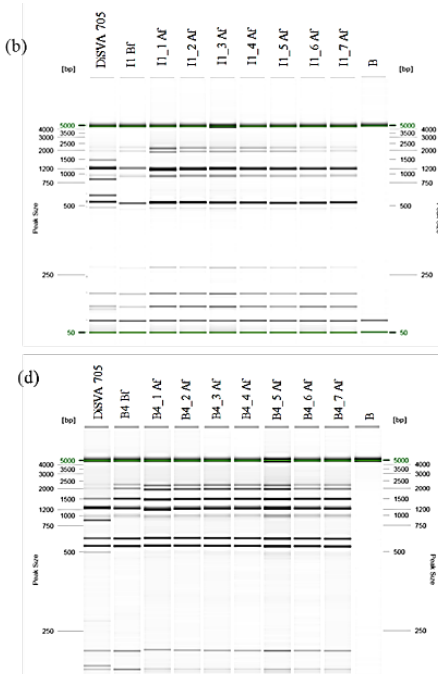
Figure 3. Electrophoretic profiles of interdelta sequences obtained by primer pair δ 12–21. Each stable isolate, belonging to each group, was named from 1 to 7 preceded by strain’s name and compared with the same unstabilized strain. The DiSVA 705 strain was used as control. The acronyms “Bf” and “Af” were used to indicate before and after genome stabilization, respectively. Lane B: indicated as negative control. The QX Size Marker 50 bp/ 5kb (Qiagen) was used for fragment size. ( a – d ) represent the electrophoretic profiles of G4, I1, I4 and I4, before and after stabilization, respectively.